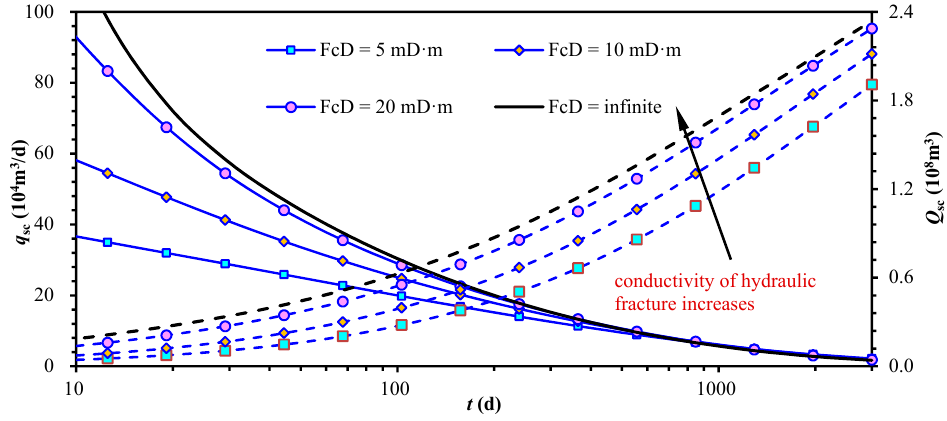
Figure 16. Effect of Hydraulic Fracture Conductivity on Production of a MFHW in Shale.